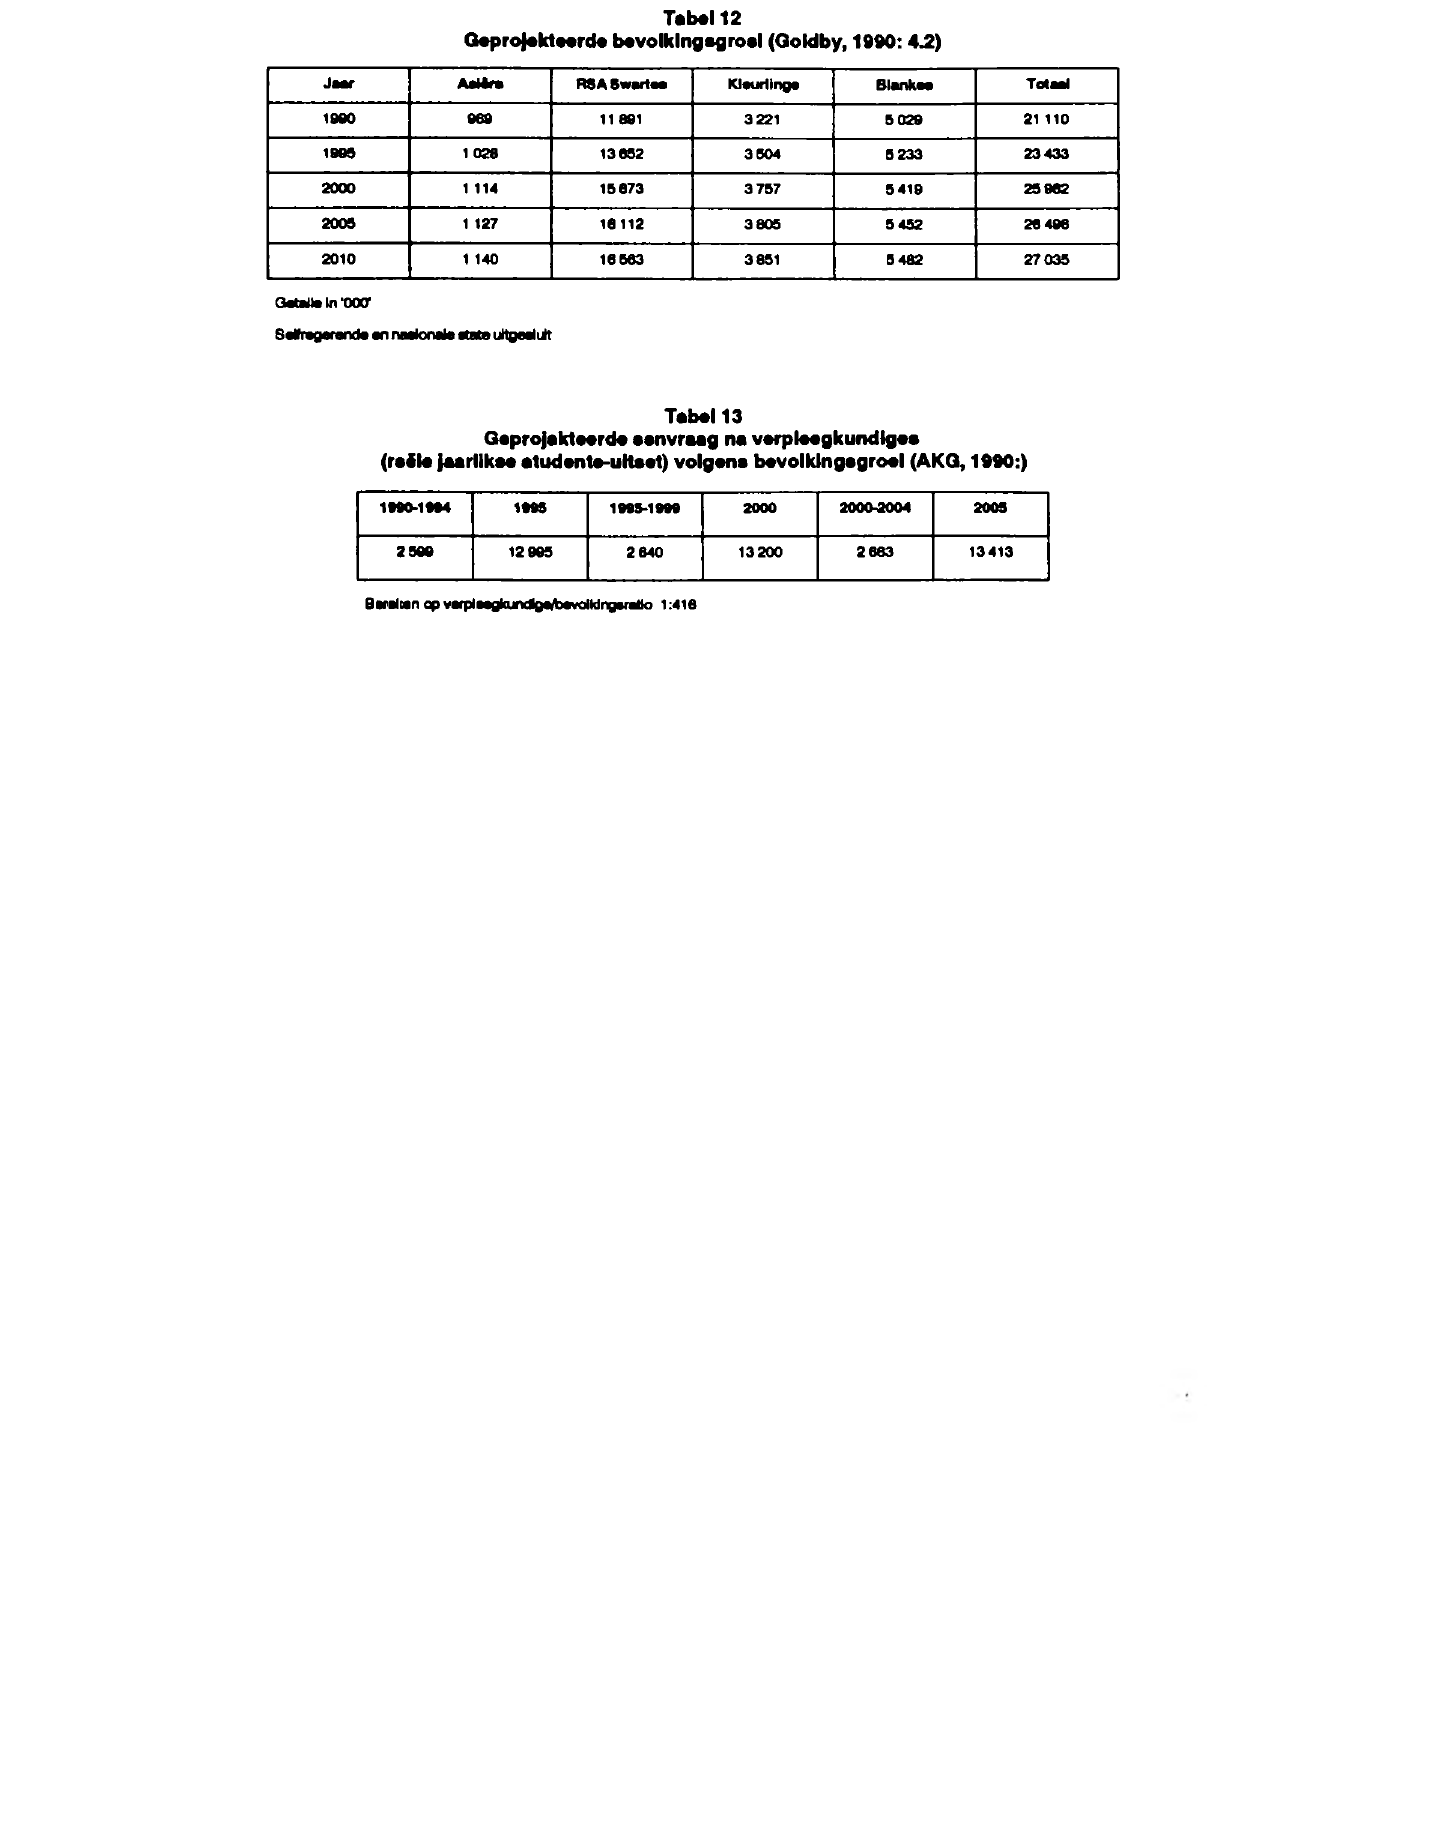
Tabal 12 Qaprojaktaard* bavolklngagroal (Goldby, 1990: 42)